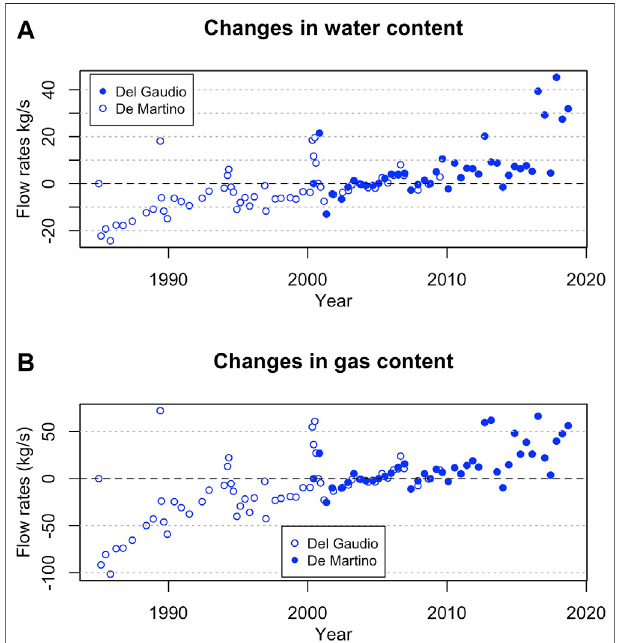
FIGURE 7| Fluid fl ow rates leaving (negative values) or entering (positive values) the hydrothermal reservoir required to justify the observed displacement in thecase of (A) liquid waterand (B) gas.Valuesarecomputed based on the observed displacement published by Del Gaudio et al. (2010) (opendots) and DeMartino et al.(2014) (soliddots). See text for further discussion.